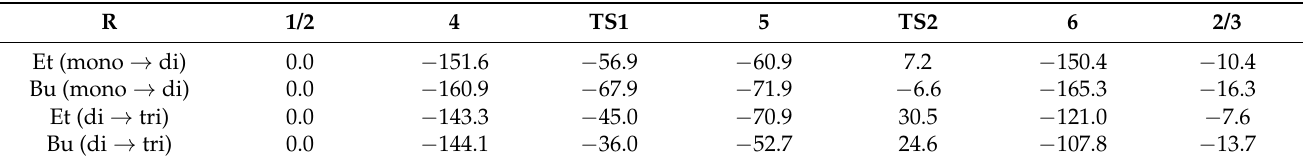
Figure 1. Enthalpy diagram for the monoalkylphosphate → dialkylphosphate → trialkylphosphate transformations obtained by DFT computations at the M062X/6–311+G (d,p) level of theory consid- ering the solvent effect of the corresponding alcohol. 2.3. MW-Assisted Alkylation of Dialkylphosphates We saw that the dialkylphosphates ( 2 ) resisted undergoing further esterification to the triesters ( 3 ) that is due to the high barrier of the activation enthalpy. Hence, the con- version of diesters 2 to trialkylphosphates 3 had to be carried out by another method, by